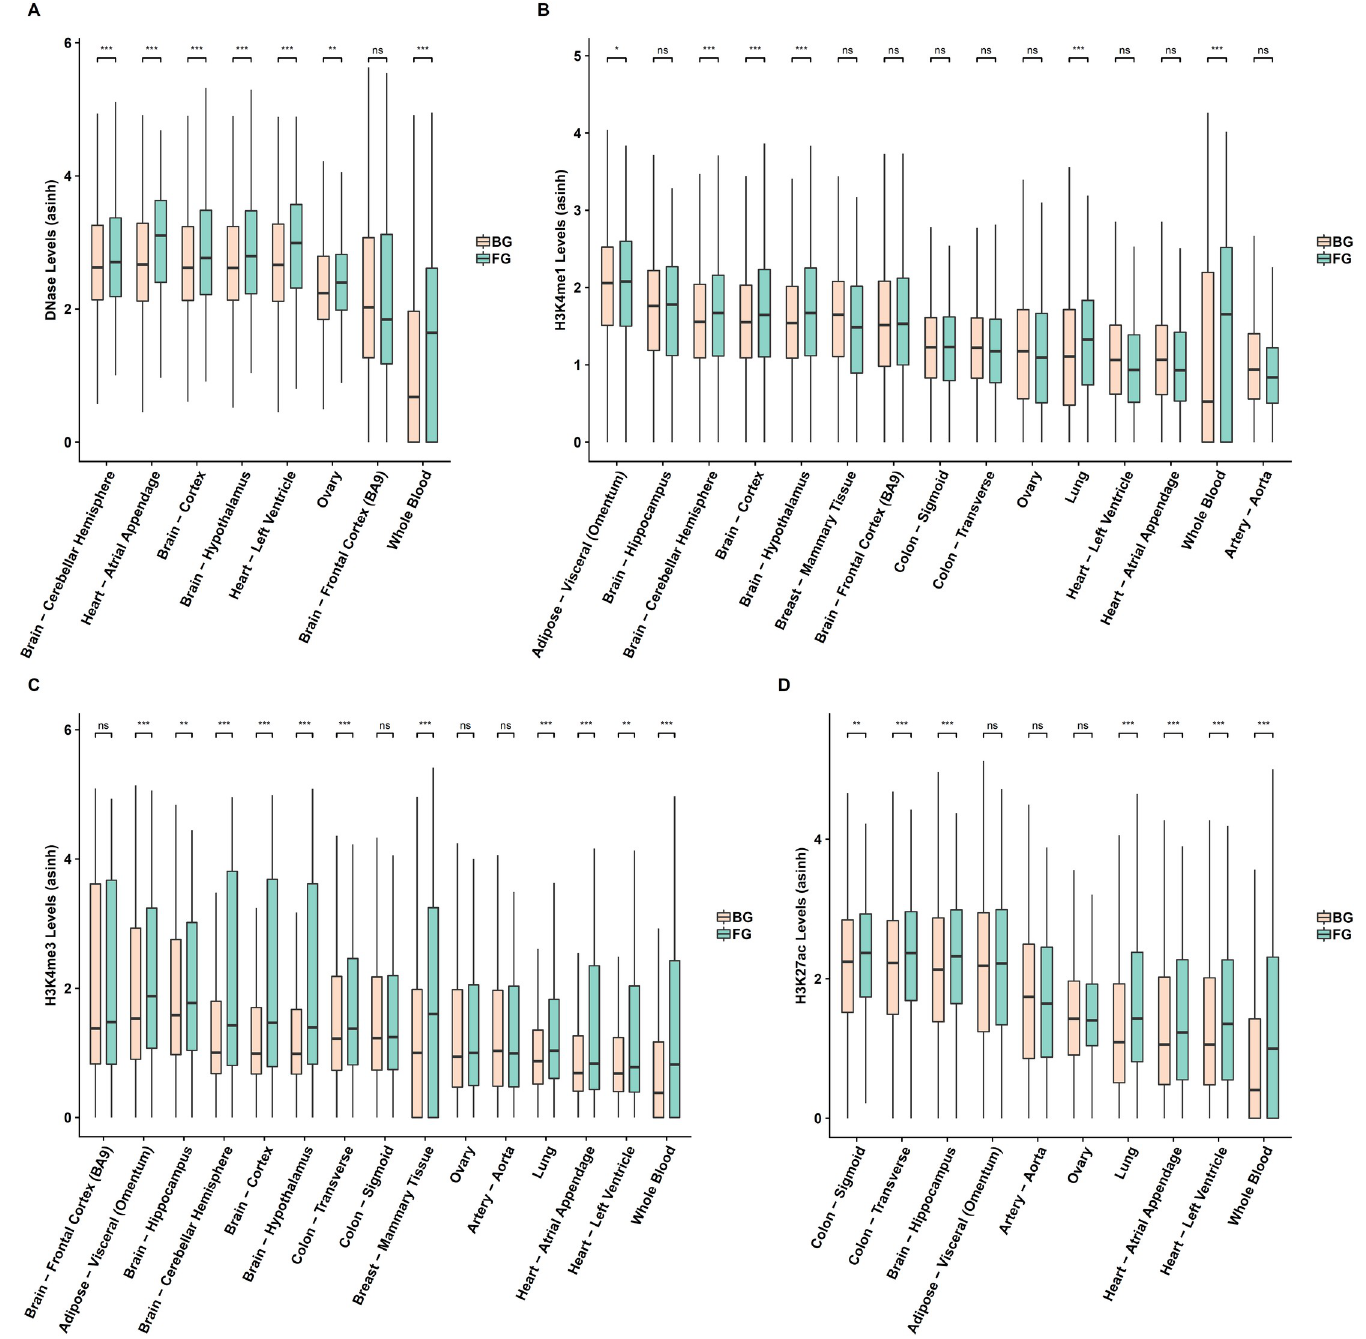
Fig 4. Detected SNPs are enriched for epigenomic markers of regulatory regions. (A)-(D) Epigenomic signal comparison between the foreground and control SNPs for open chromatin (DNase), H3K4me1, H3K4me3, and H3k27ac respectively. The foreground is 200 bps windows around the detected SNPs (blue) and the control is 200bps windows around the control SNPs